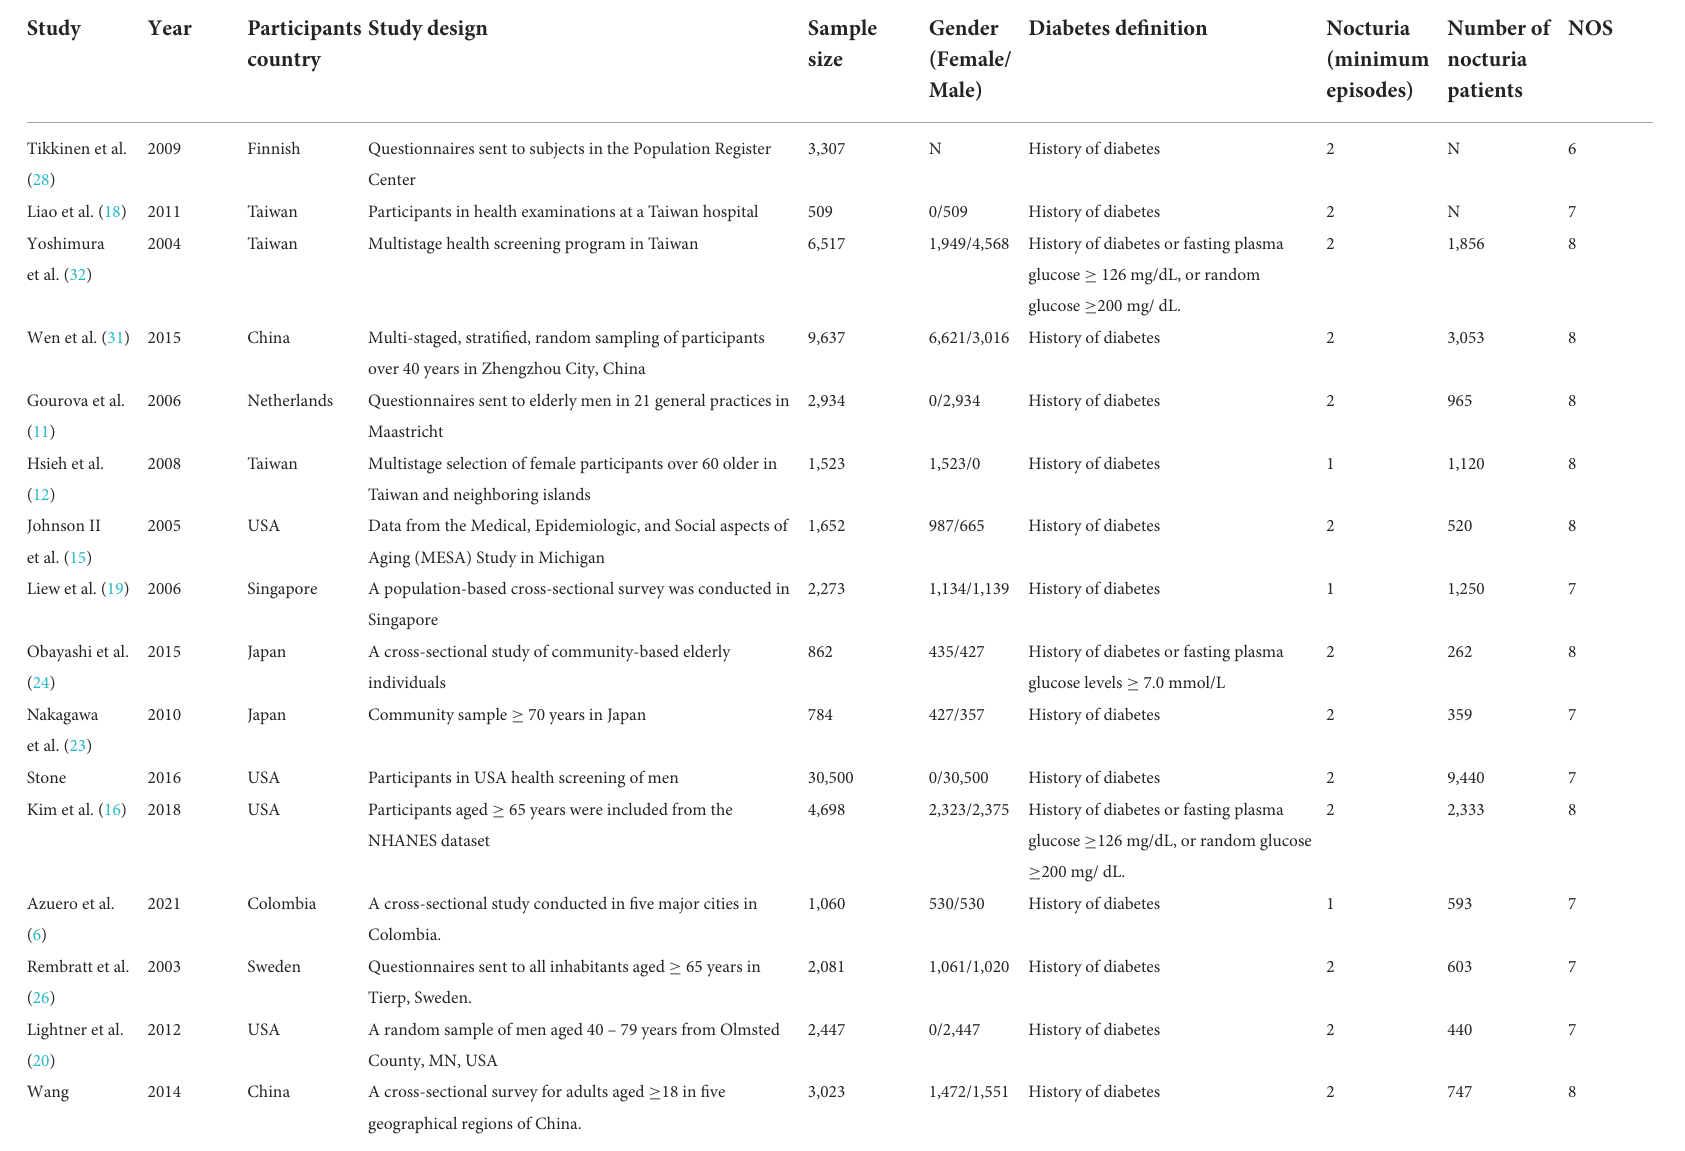
TABLE 1 Basic characteristics and data of included